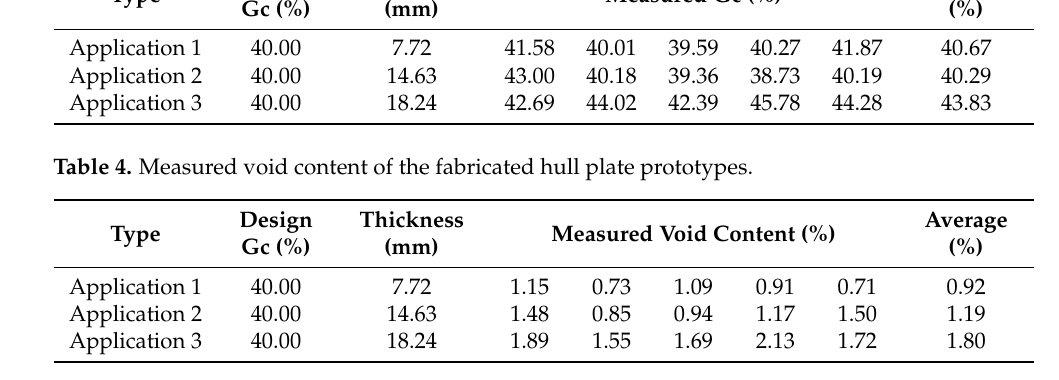
Figure 2. Thickness measurement for each hull plate prototype: ( a ) top view and ( b ) isometric view. A burn-off test was performed to measure the Gc values and void contents [18].